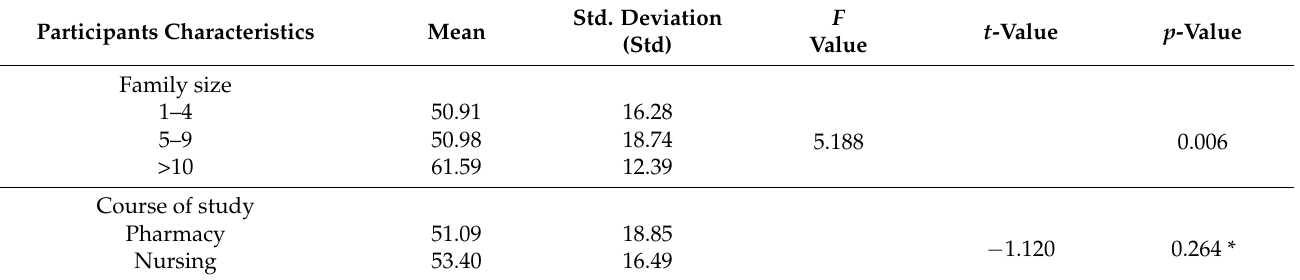
Table 4. Association between attitude score and student’s